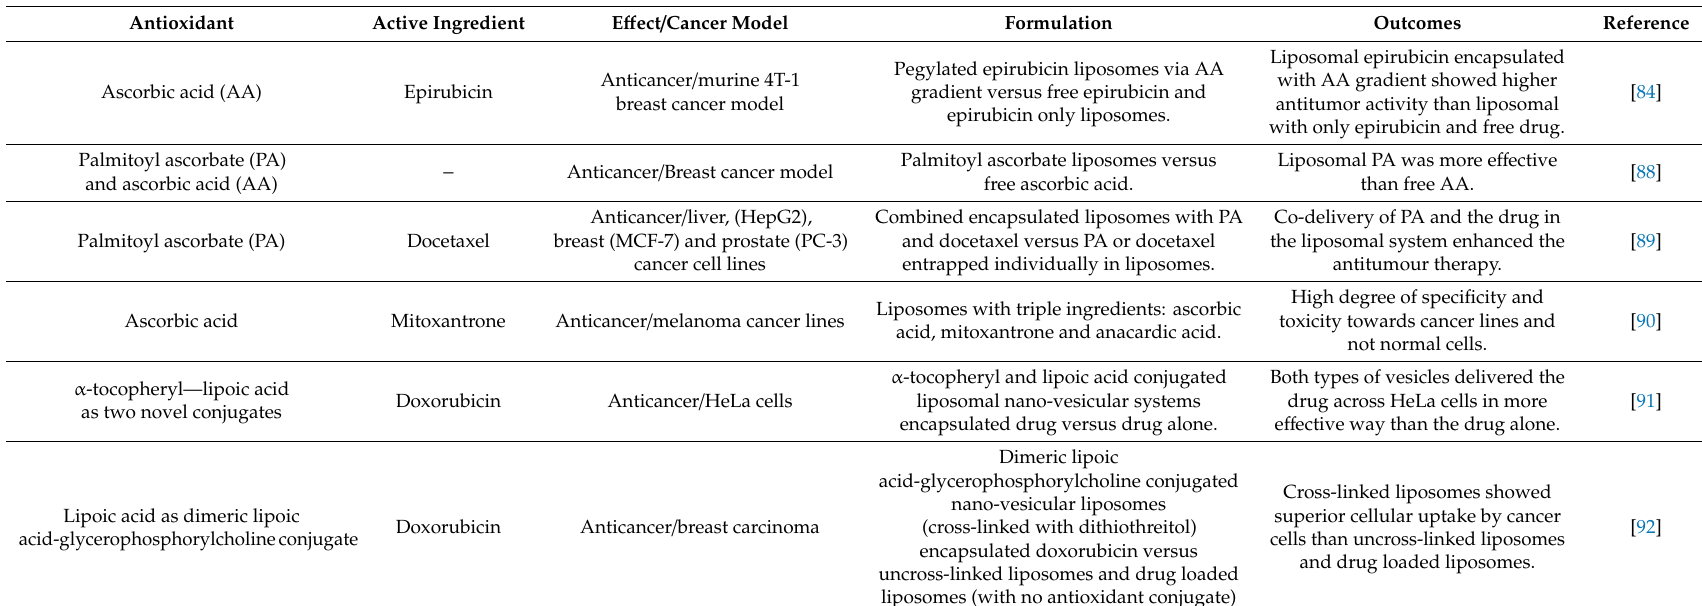
Table 1. The e ff ects of antioxidants, ascorbic acid and lipoic acid in liposomal forms on cancer